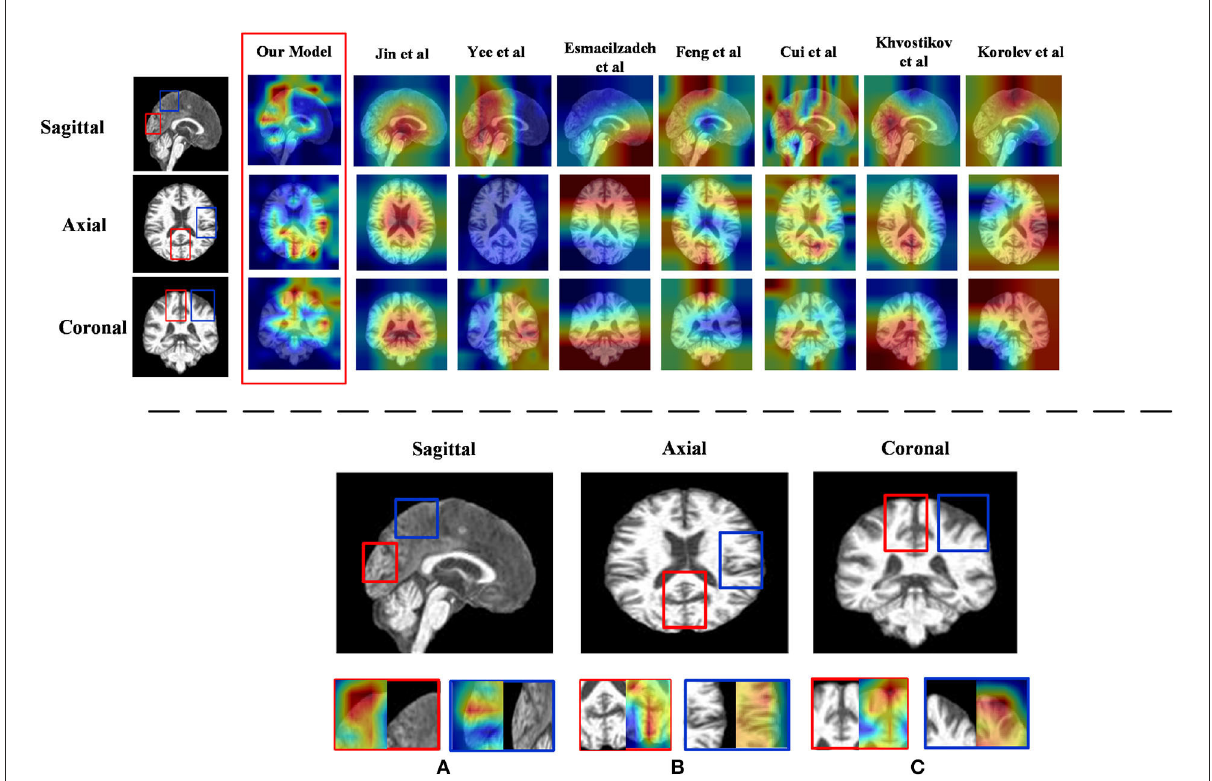
FIGURE4 Heatmap visualization of three views of an MRI from ResRepANet and its competing methods(upper panel) and discriminative regions identified by ResRepANet on AD classification (lower panel). In lower panel (A) the Sagittal view of MRI and (B) the Axial view of MRI while the Coronal view of MRI as (C) the heatmaps show the information suggested by attention weights, where the red color denotes the model focus on the regions of locations. The red outlined boxes representing the thalamus belong to the temporal lobe, while the blue outlined boxes represent the cerebral cortex belonging to the parietal